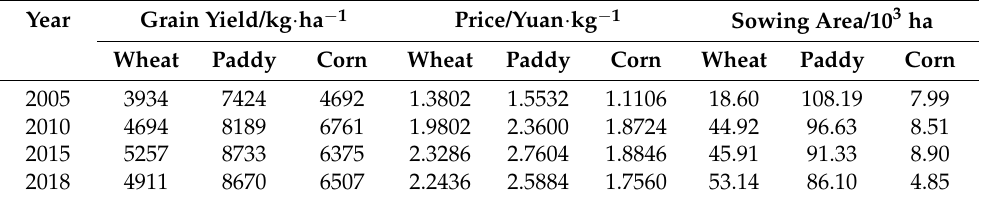
Table 2. Grain yield, price, and sowing area of Nanjing in 2005, 2010, 2015, and 2018.